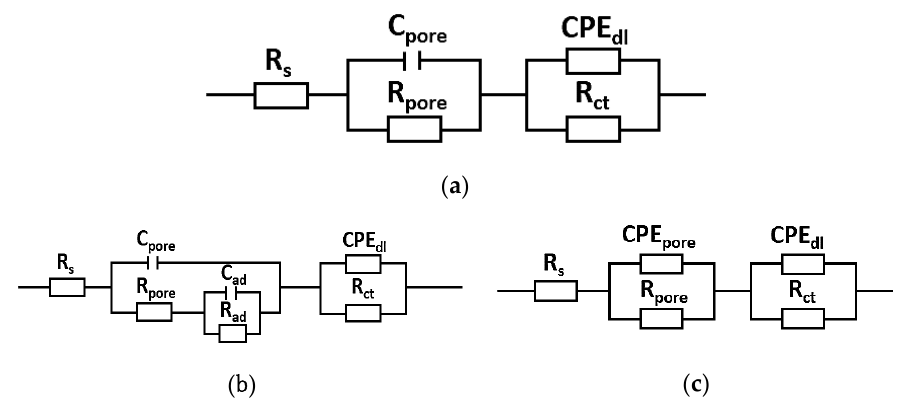
Figure 8. Electric substitute scheme ( a ) M1 pH = 7.4 and pH = 5; ( b ) M2 pH = 7.4; ( c ) M2 pH = 5. According to this model, the two R, CPE/C elements are connected in series with the Ringer solution resistance R s . The model describes the formation of two loops in a Nyquist plot. The activity of the oxide layer/deposited ZnO layer is characterized by a high-fre- quency loop, which diameter depends on the potential. This is determined by the serial resistance R pore (electrolyte resistance in the porous phase) and the space charge capaci- tance C pore /CPE pore (capacity of the double layer-porous surface). The low-frequency loop corresponds to the surface boundary of the oxide layer solution, and the R ct (characterizes